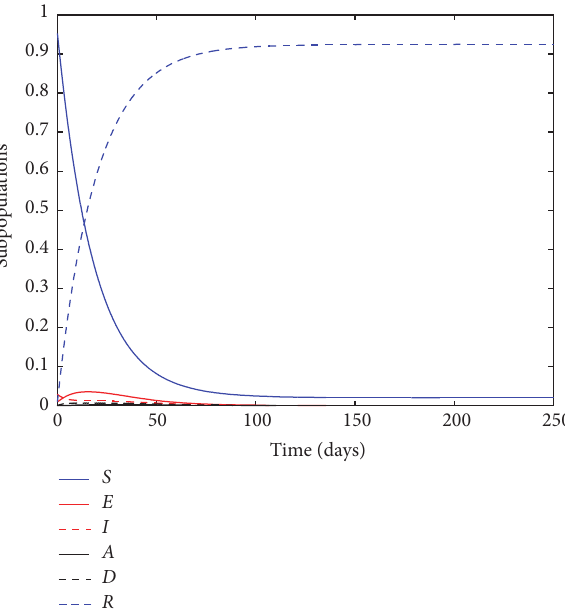
Figure 14: Evolution of the subpopulations with daily culling rate of = 0.1 and constant vaccination of 𝑉 = 𝑉 𝜌 𝐷